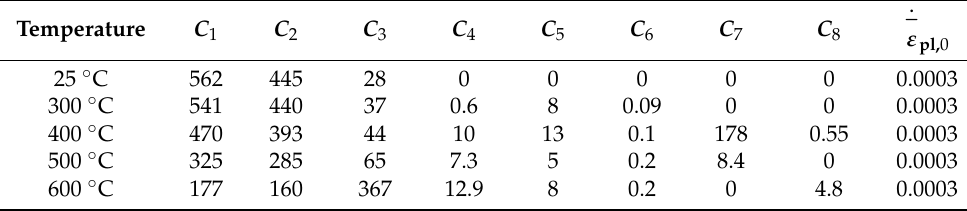
Table A1. Flow curve extrapolation